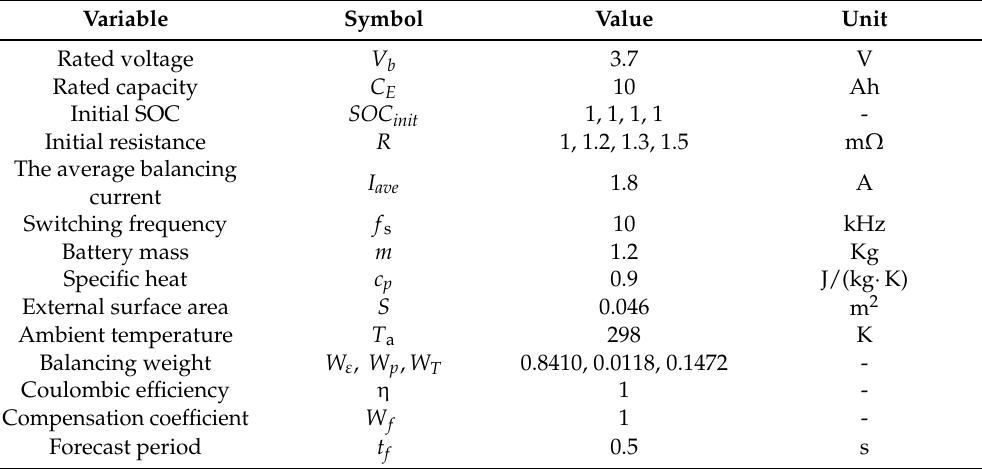
Figure 5a–d are the simulation results of the degradation rate under conditions of non-balancing, SOC balancing, multi-objective balancing and MOPBC, respectively.